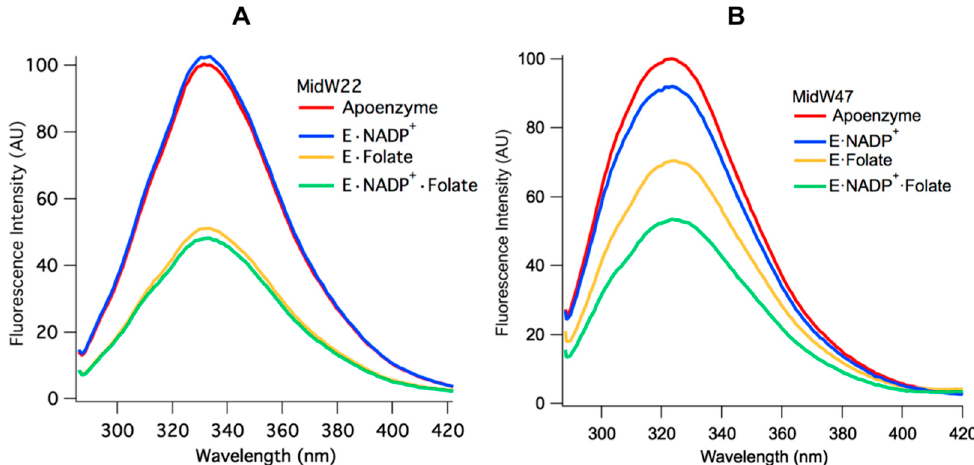
Figure 4. Equilibrium Trp fluorescence of midW22 ( A ) and midW47 ( B ) and their ligand complexes (3 μ M enzyme with 6 μ M folate and/or 6 μ M NADP + ). The Trp fluorescence of midW22 appears to be primarily modulated by the presence of folate, whereas the Trp fluorescence of midW47 changes with each ligand complex.